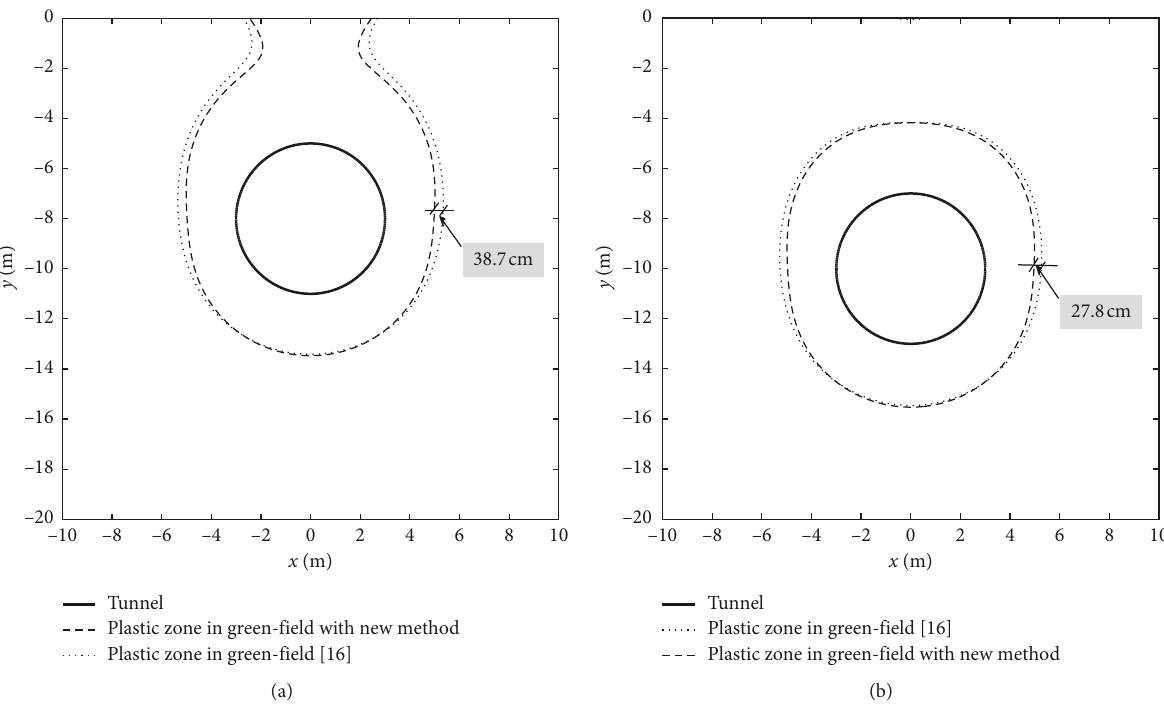
Figure 3: Comparisons of potential plastic zones in green-field. (a) Relative depth � 0.83. (b) Relative depth �